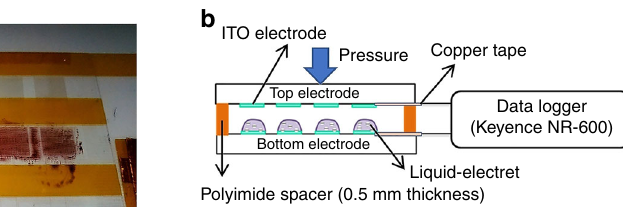
while in case of only textile, no such mechanoelectrical effect was observed (Fig. 5i).